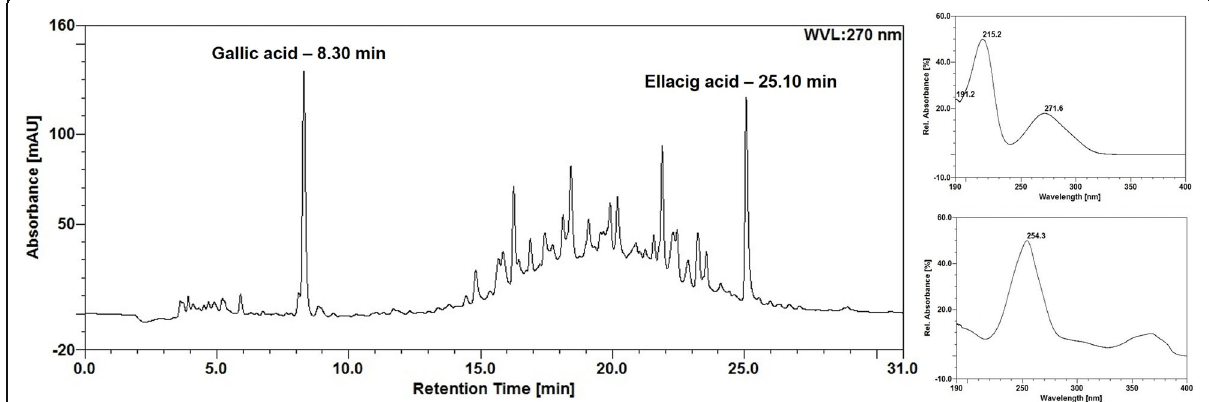
Fig. 1 Chromatographic profile of LfAE and UV-spectrum of the standards (gallic acid - 8.30 min and ellagic acid - 25.1 min)